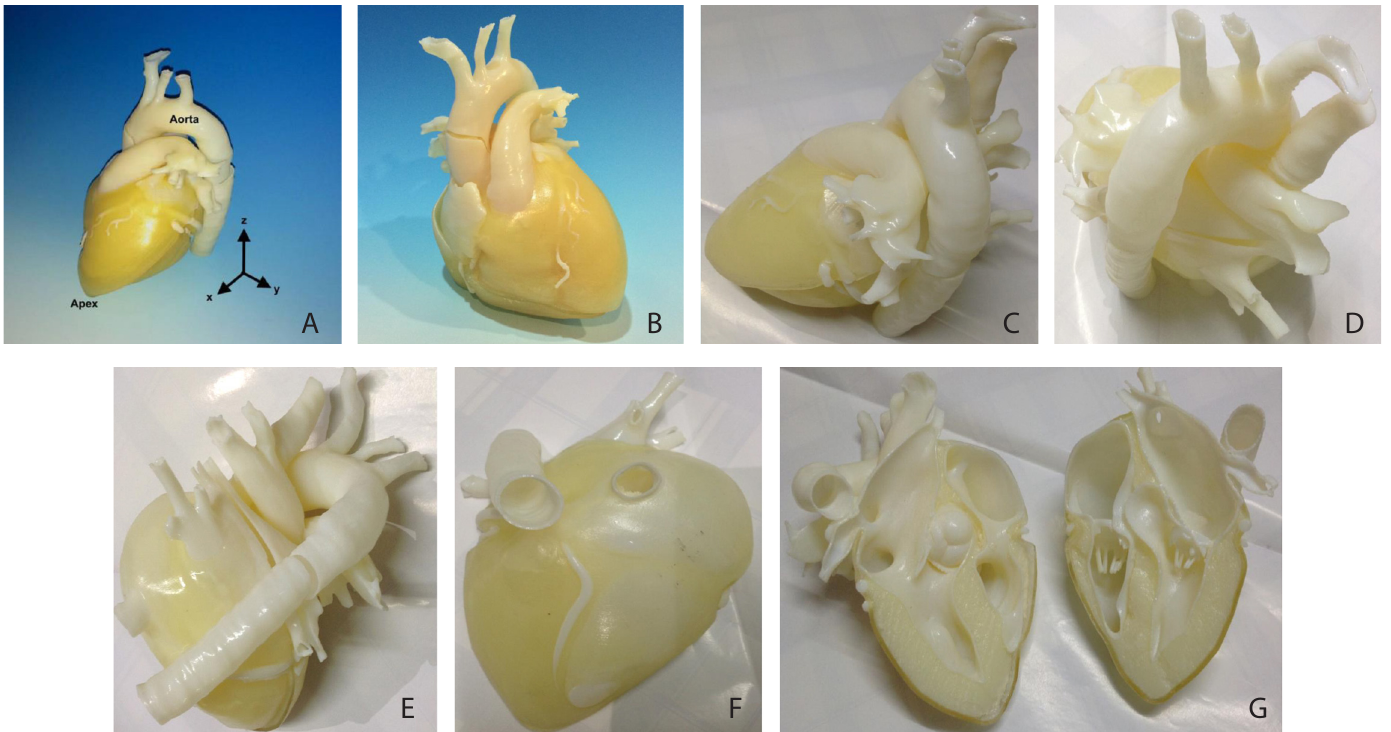
Fig. 2 - A) – Three-dimensional printed normal heart bio model. The myocardium (yellow area) is clearly visible in the model (left anterior oblique 60˚ view). B) - Posterior anterior view of heart model. C) - Left lateral view of the heart model. D) - Craniocaudal (superior) view of the heart model. E) - Posterior view of the heart model. F) - Inferior (caudal) view of the heart model. G) - Cross-sectional view of the heart